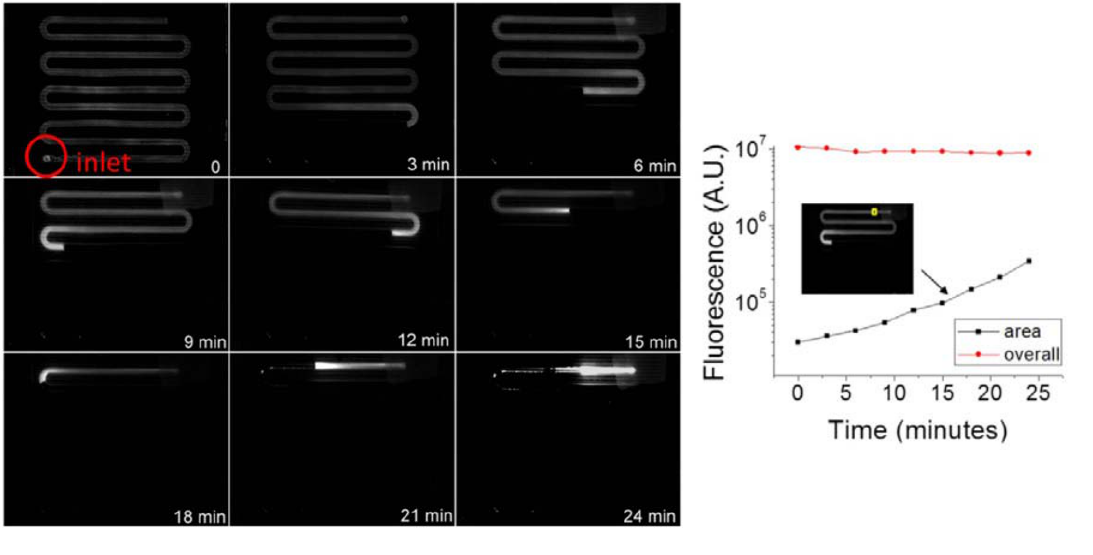
Figure 3. Concentration of 100nm Fluorescent beads in the evaporator. Left : representative fluorescent images of the channel over time. Right : fluorescence inside the entire channel and in a 1mm 2 area near the outlet over